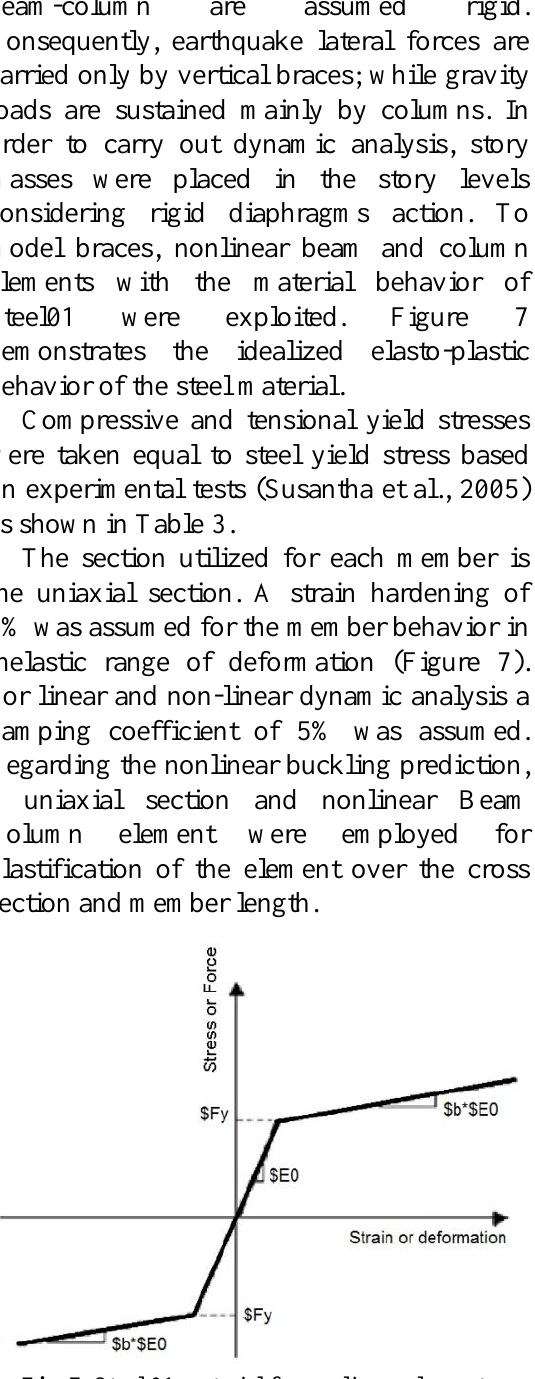
Fig. 7. Steel 01 material for nonlinear elements (Mazzoni et al.,